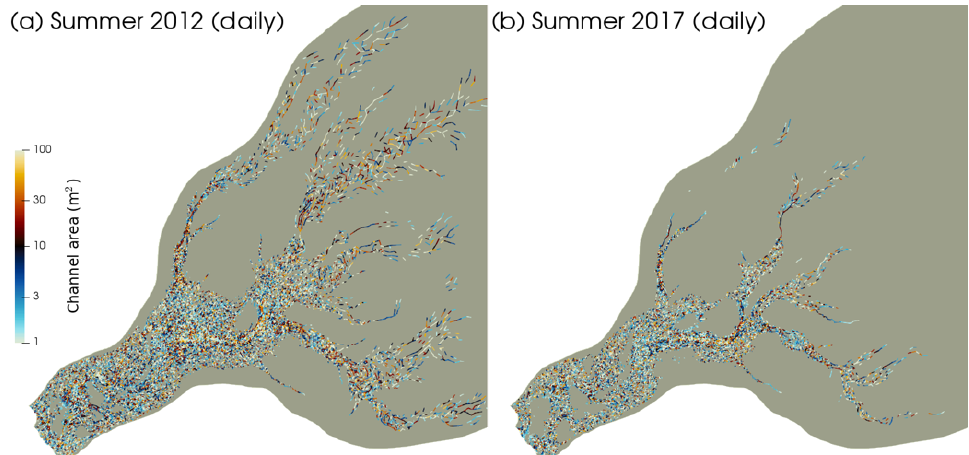
Figure 9. Maximum extent of channelised subglacial drainage in (a) the SummerDaily12 run on 31 July and (b) the SummerDaily17 run on 14 August. It is instructive to compare these two panels with panels (c) and (d) of Fig. 5 to show the variability of the channelised system over a melt